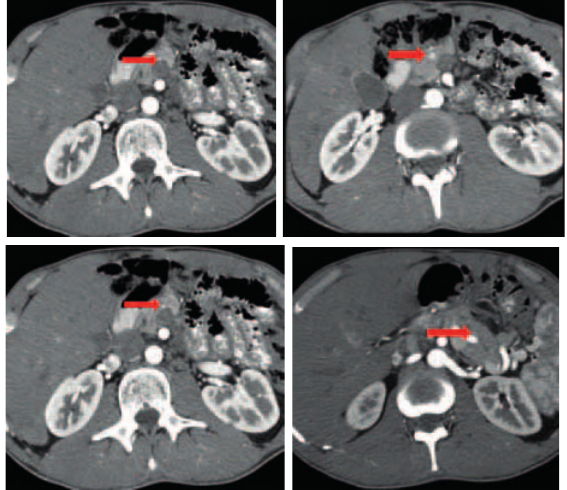
Figure 2. Computer tomography scans of the abdomen (multiple foci in the pancreas).